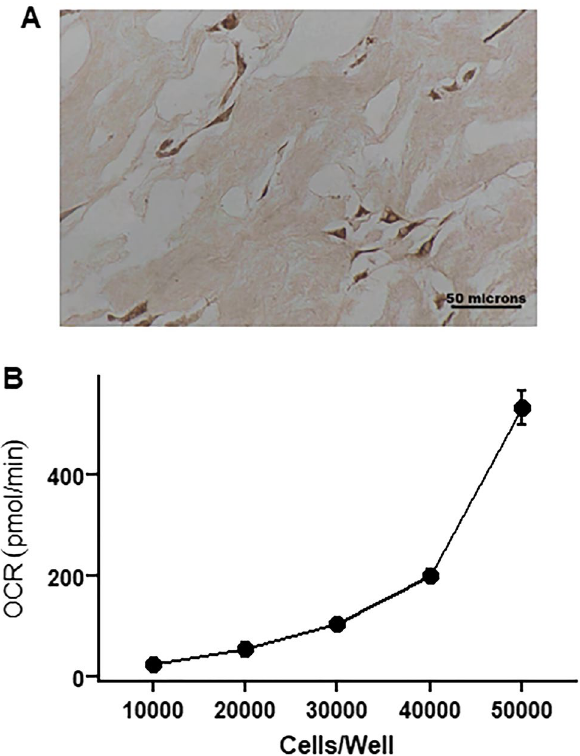
Figure 7. MSC characterization. ( A ) MSCs in umbilical cord tissue sections stained for CD105 antigen. ( B ) Basal oxygen consumption of MSCs seeded at different densities. MSCs —mesenchymal stem cells. OCR — oxygen consumption